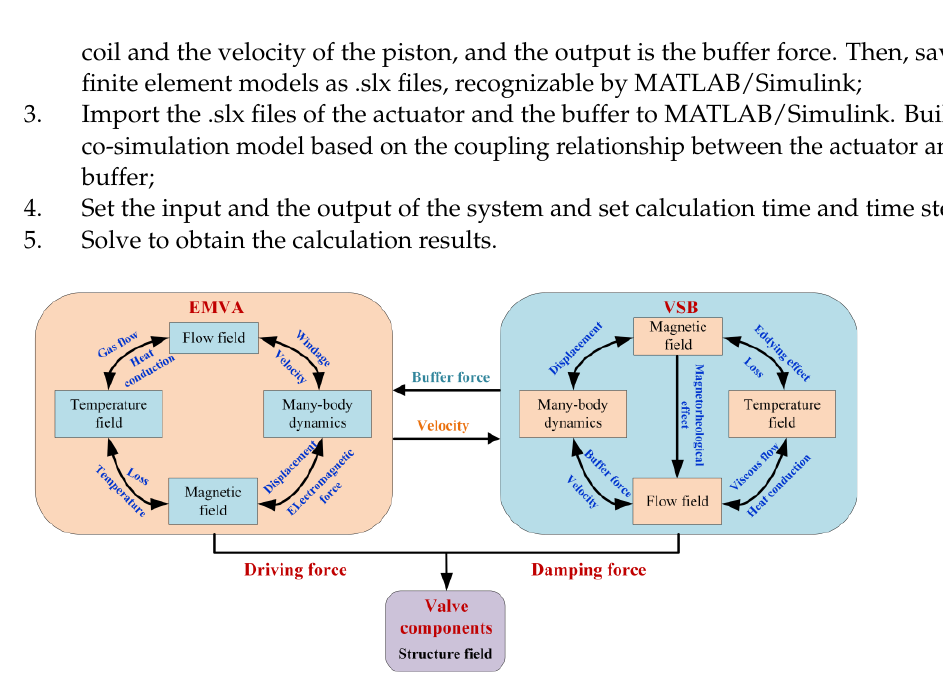
Figure 14. Coupling relationship of EMVV system.